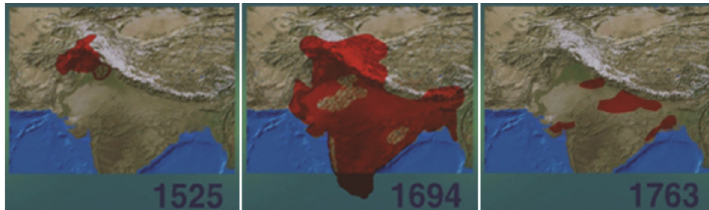
Fig. 2. Example of a temporal animation (selected frames) presenting the changing area of the Mogul